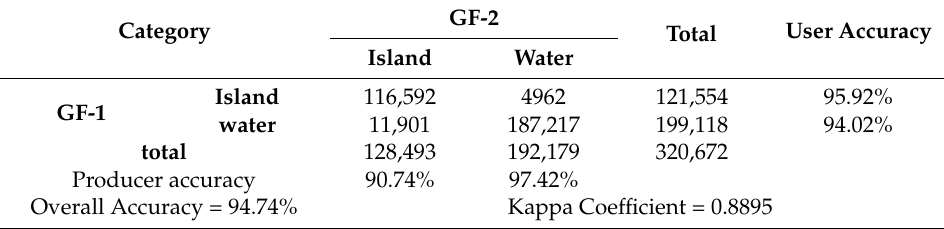
Table 2. Confusion matrix obtained by NDWI methods.